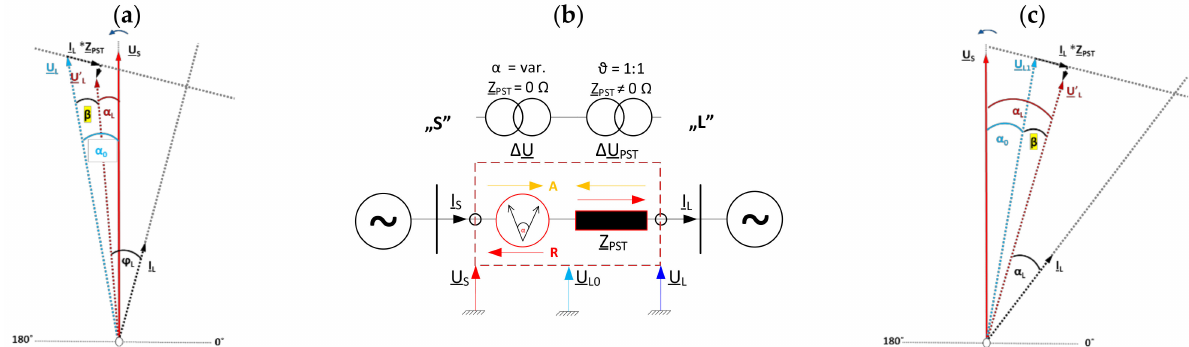
Figure 6. ( b ) PST representation model for a load condition study and relevant vector diagrams visualization for load condition impact on the phase shift for ( a ) advance and ( c ) retard